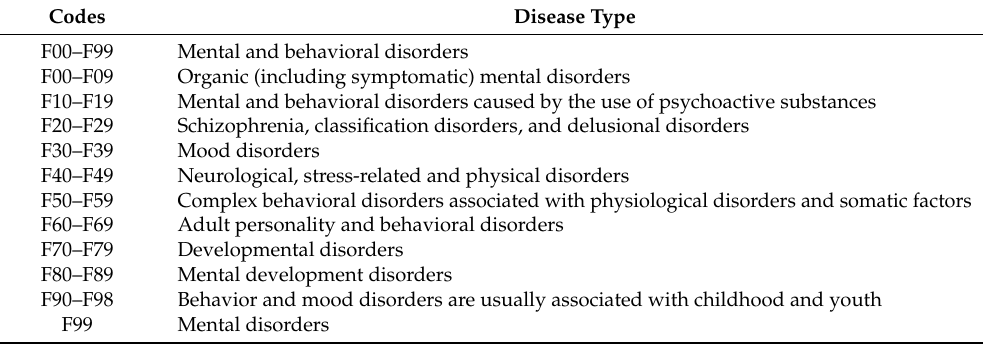
Table 1. Disease types of the International Classification of Diseases (ICD 10: F00–F99).